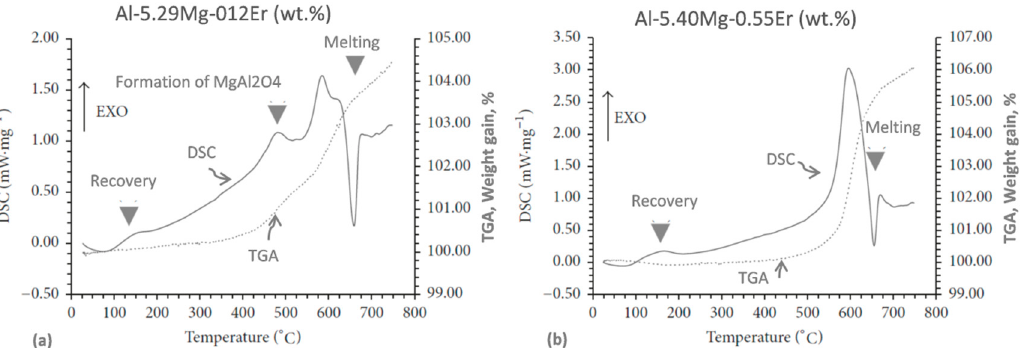
Figure 11. Application of DSC/TGA combination to study thermal stability of Al − Mg − Er alloys: ( a ) Al − 5.29Mg − 012Er (wt.%); ( b ) Al − 5.40Mg − 0.55Er (wt.%). The characteristic temperature of solidus being 575 °C and recrystallization at ~330 °C are not detected by DSC [47].